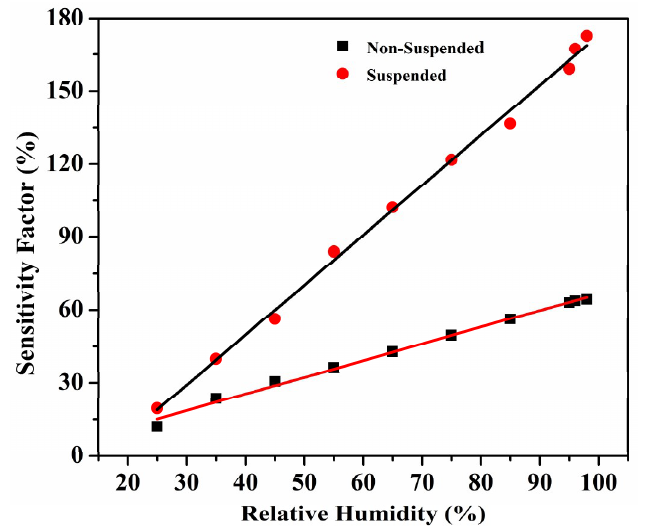
Figure 5. Sensitivity factors of suspended CNTs vs. non-suspended CNTs.